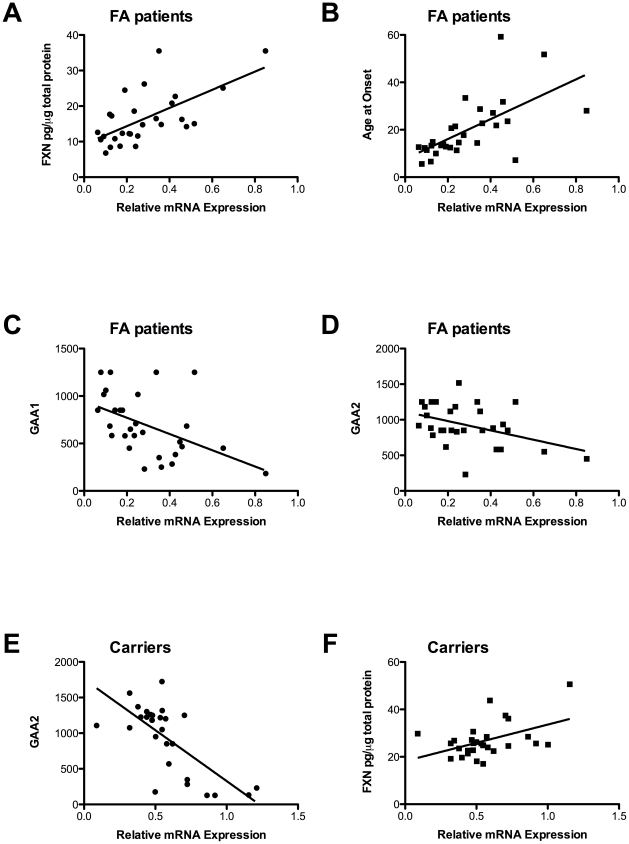

FXN mRNA correlation analysis.A) correlation between FXN mRNA and protein levels cFA and LOFA patients (p<0.001, R2 = 0.4058); B) correlation between FXN mRNA levels and age at onset in cFA and LOFA patients (p<0.0001, R2 = 0.3905); C) correlation between FXN levels and GAA1 for cFA and LOFA (p<0.01, R2 = 0.2364); D) correlation between FXN levels and GAA2 for cFA and LOFA (p<0.05, R2 = 0.1750); E) correlation between FXN mRNA levels and GAA2 for carriers (p<0.0001, R2 = 0.4667); F) correlation between FXN mRNA and protein levels in carriers (p<0.02, R2 = 0.2167).